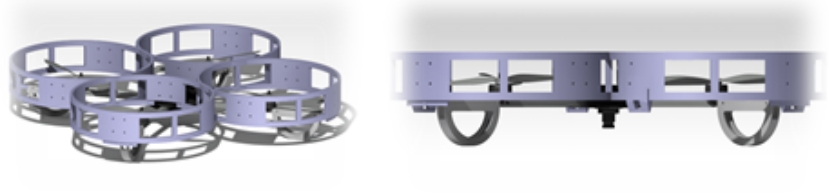
Figure 4. 3D Design of the